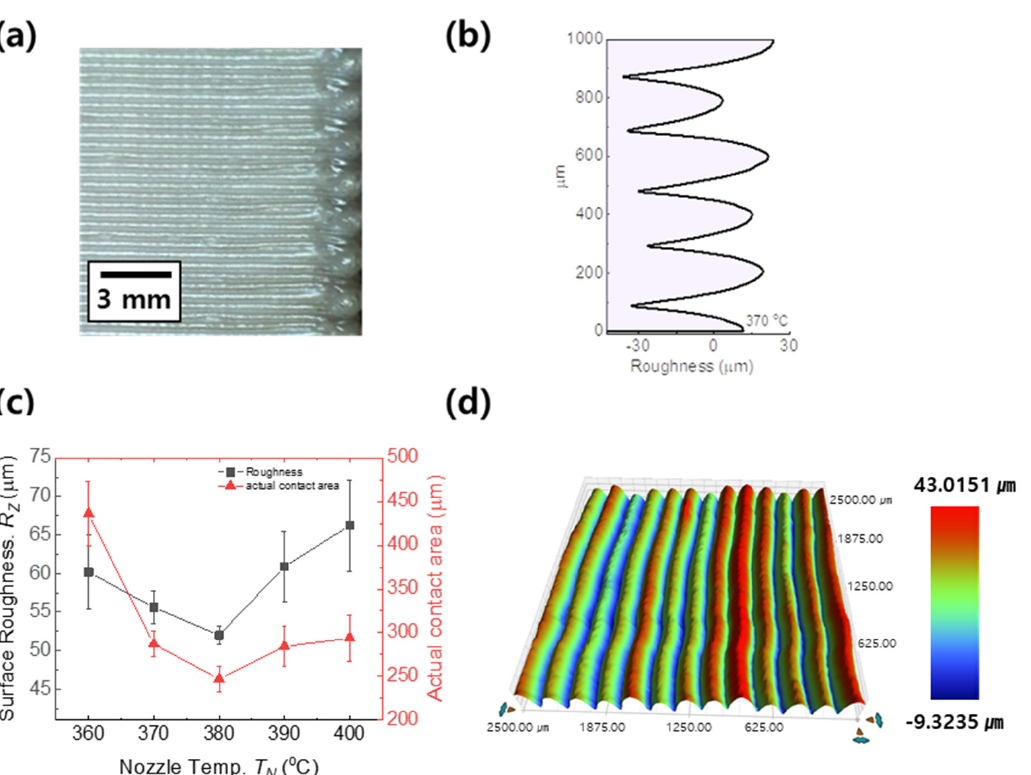
Figure 3. The surface morphology of side parts on specimens: ( a ) side view of the printed structure, ( b ) 2-D surface roughness at 370 °C, ( c ) comparison on surface roughness between different T N , and ( d ) 3-D mapping image of surface morphologies.